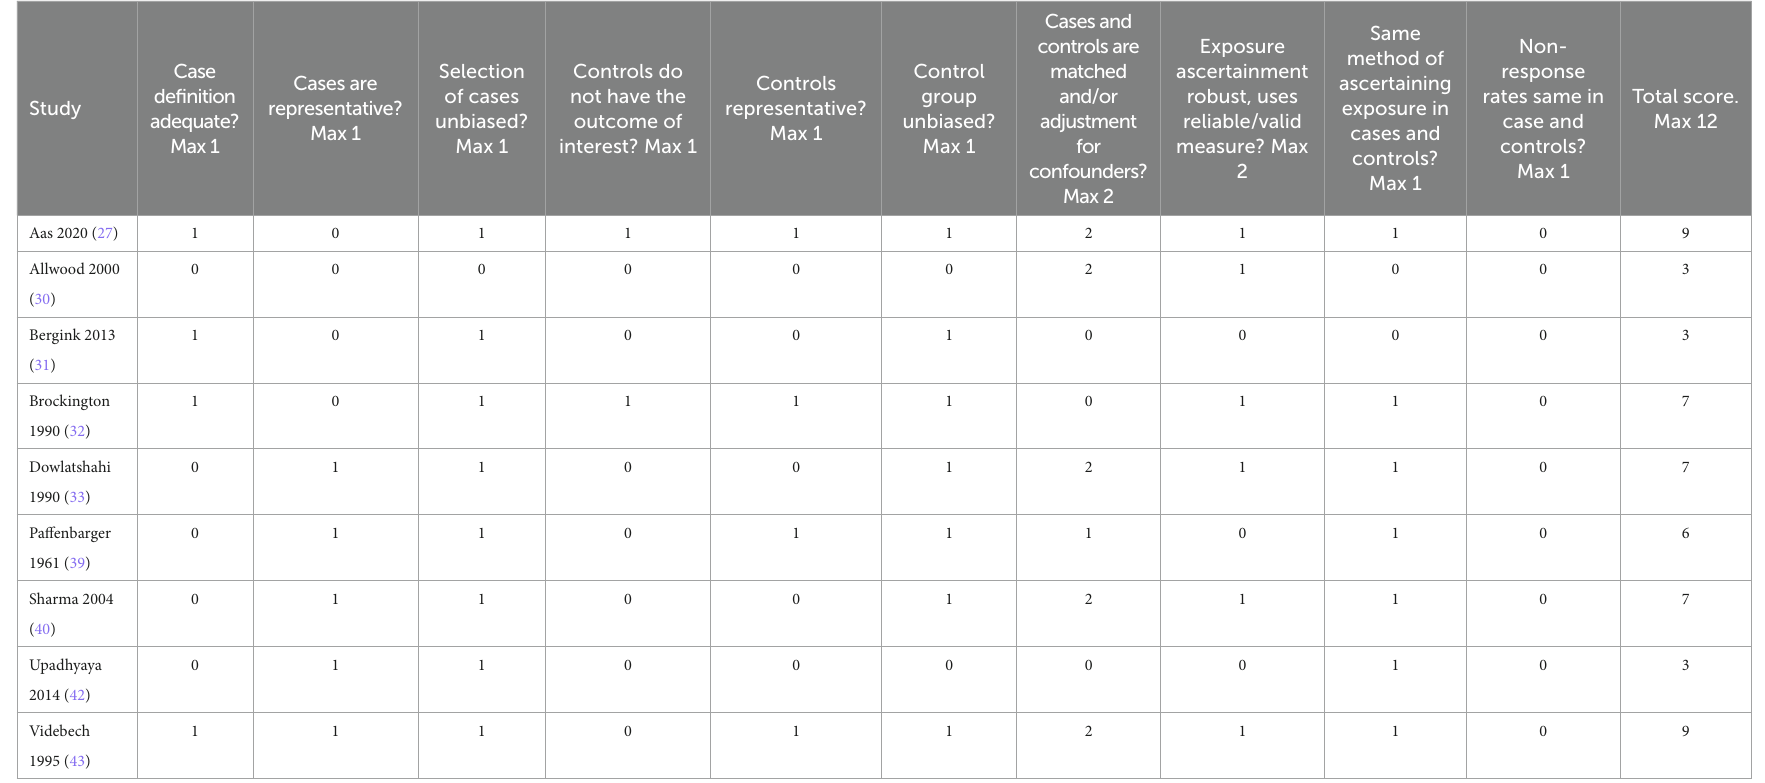
TABLE 4 Risk of bias in case–control